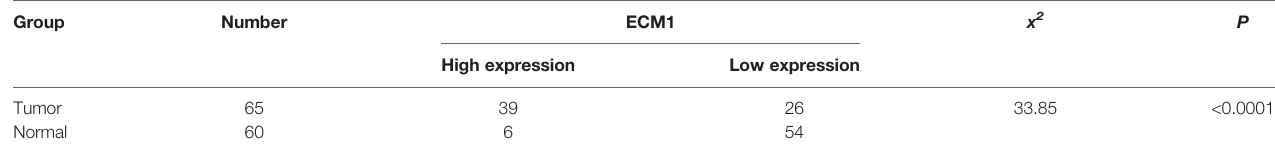
TABLE 1 | ECM1 expression levels in CRC tumors and paracancerous tissue samples.